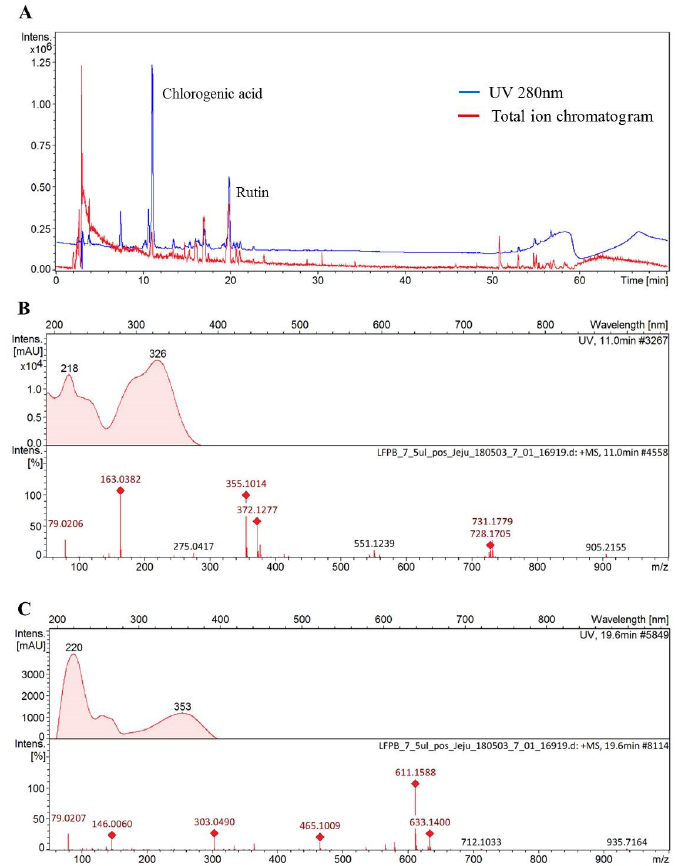
Figure 6. Chromatogram of Dendropanax morbifera leaf extract obtained at the optimum conditions at 280 nm ( A ), mass spectra for chlorogenic acid ( B ), and rutin ( C ). samples identified and confirmed using standard of reference.